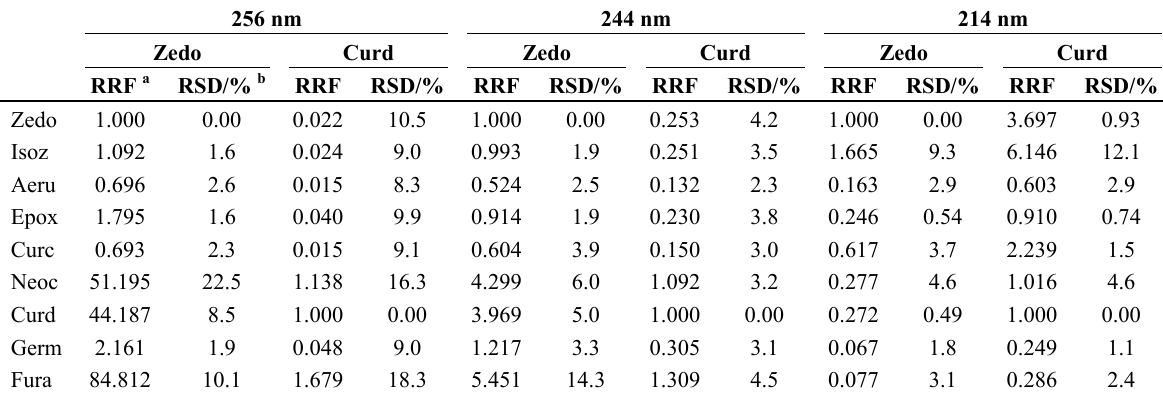
Table 5. Variations of RRFs on different columns and